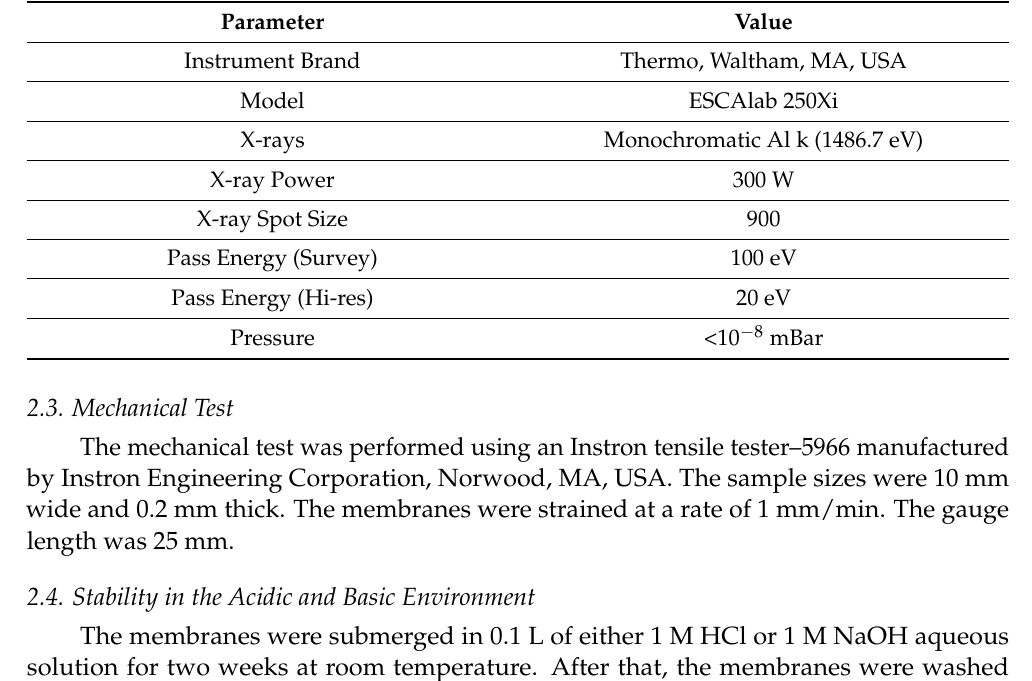
Table 1. Experimental setup for X-ray photoelectron